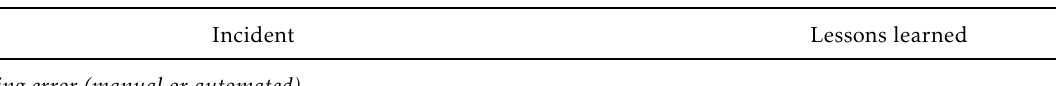
Table 4 – UAS incidents experienced by the